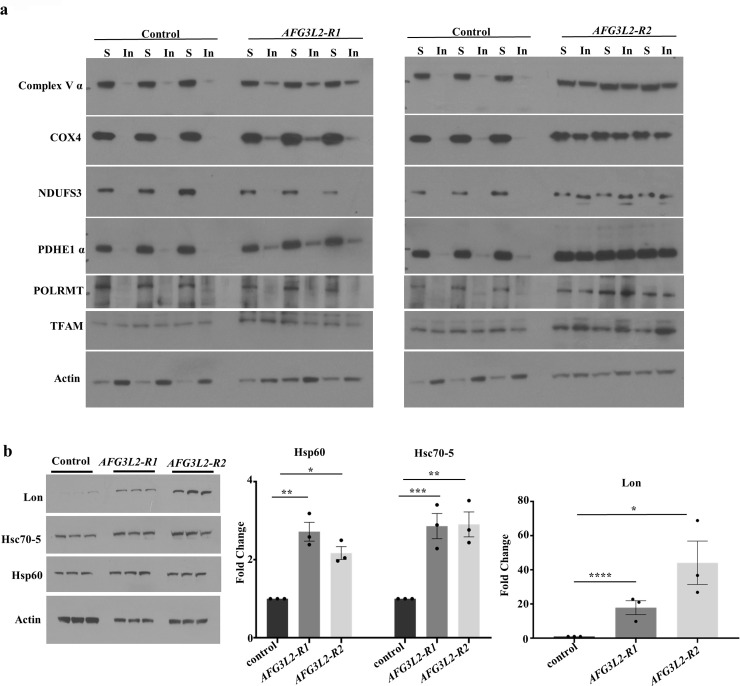
Afg3l2 deficiency results in the accumulation of insoluble mitochondrial proteins and activation of the mito-UPR.a. Results of western blot analysis of triton-soluble (S) and insoluble (In) mitochondrial protein fractions from control (UAS-LUCIFERASE RNAi/da-Gal4) and AFG3L2-deficient (AFG3L2-R1; UAS-AFG3L2-R1 RNAi; da-Gal4 and UAS-AFG3L2-R2 RNAi/da-Gal4) pupae using the indicated antisera. b. Results of western blot analysis of cell lysates from control (UAS-LUCIFERASE RNAi/da-Gal4) and AFG3L2-deficient (UAS-AFG3L2-R1 RNAi; da-Gal4 and UAS-AFG3L2-R2 RNAi/da-Gal4) pupae using antisera to the mito-UPR markers Lon, Hsp60A and Hsc70-5. Quantification was performed after normalizing band intensity of each protein to actin (N = 3 independent groups of 5 pupae, *p < 0.05, **p < 0.005, ***p < 0.0005, ****p < 0.0001 by one-way ANOVA Tukey's test for multiple comparison).